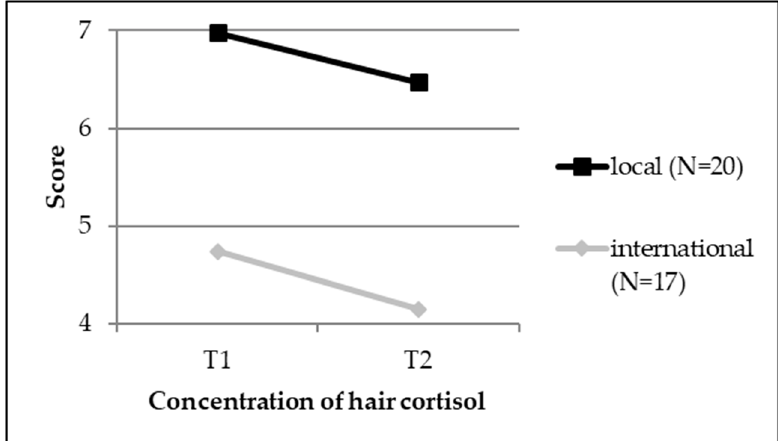
Figure 4. A line chart depicting differences between international and local students concerning the concentration of hair cortisol.